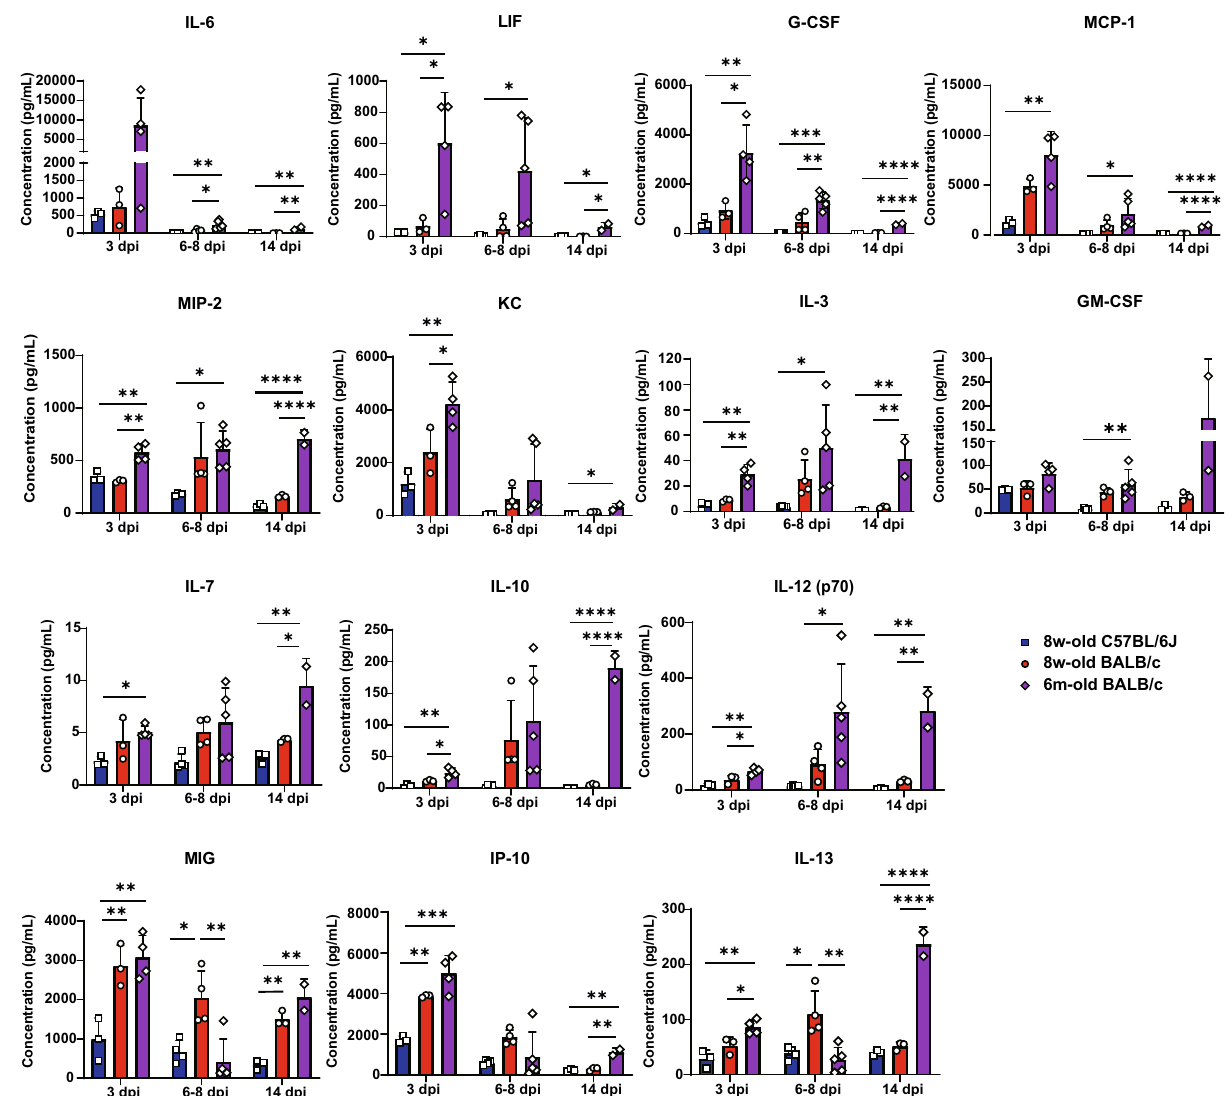
Figure 3. Cytokines and chemokines with the highest expression levels in aged BALB/c mice throughout the experimental period. Left-lung homogenates in HBSS were used to measure multiplex cytokines and chemokines using the Bio-plex suspension array system. Of the 32 cytokines and chemokines measured, 14 are shown in this figure. Data are presented as mean ± SD (young group, n = 3–4 per time point, aged group, n = 2–5 per time point). P-values were calculated using one-way ANOVA followed by Tukey’s test. Asterisks indicate significant differences among young C57BL/6 J, young BALB/c, and aged BALB/c